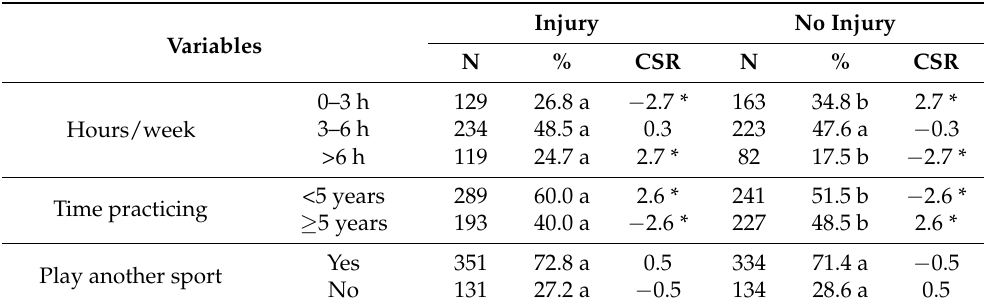
Table 6. Relationship between injury and padel practice (hours/week and time practicing) and time practicing another sport among amateur padel players.